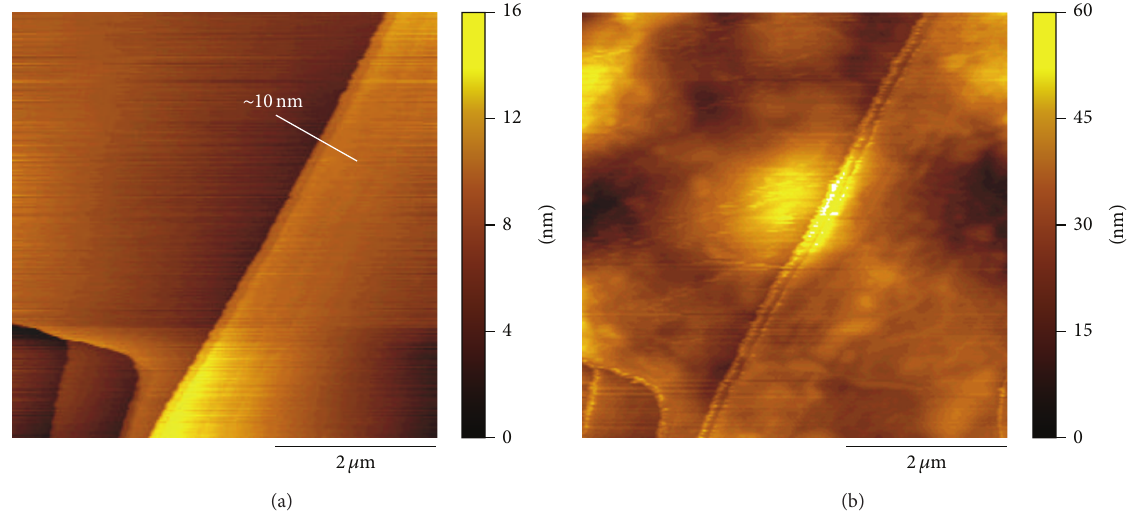
Figure 3: In situ AFM images (5 × 5 𝜇 m 2 ) of the HOPG basal plane surface obtained at 2.9 V (a) before and (b) after the first cycle CV at 5 mV s −1 in 1M LiClO 4 /EC + DEC.